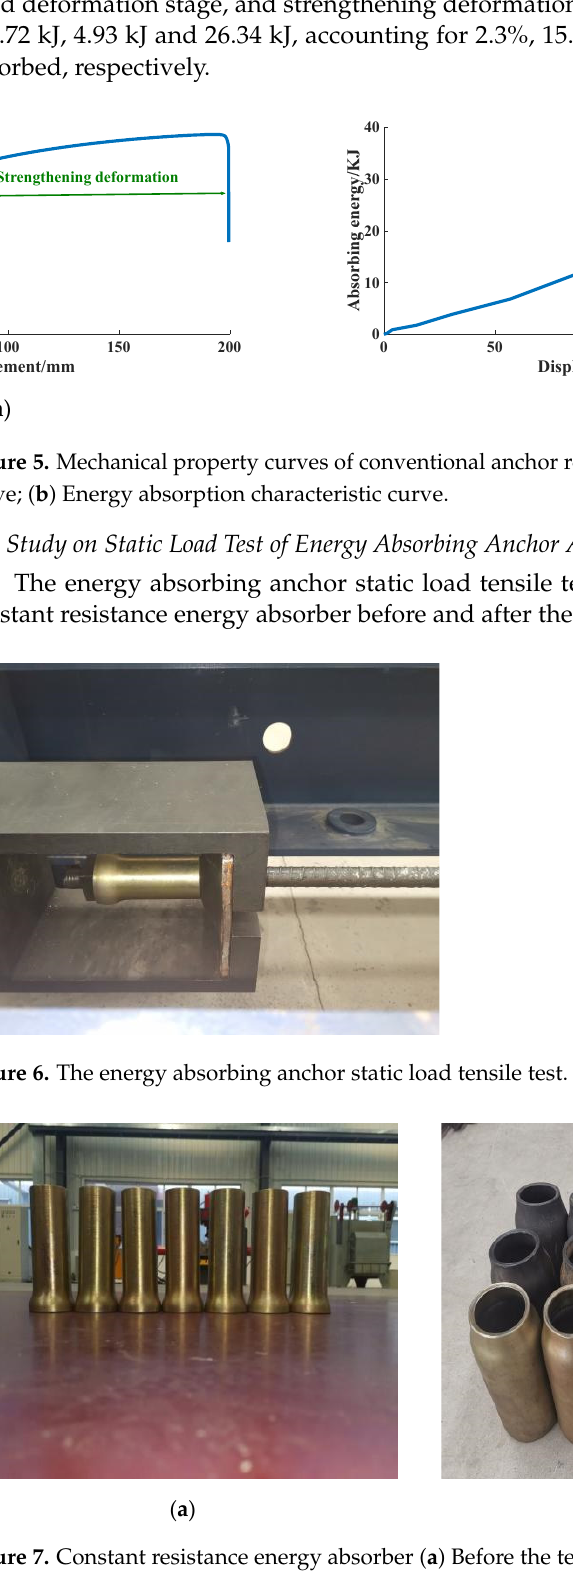
Figure 7. Constant resistance energy absorber ( a ) Before the test; ( b ) After the test. The comparison of the mechanical property curves of the conventional anchor and the energy absorbing anchor under static load is shown in Figure 8, and the comparison during loading is shown in Table 3. ( b ) Figure 8. The comparison of the mechanical property curves ( a ) bearing capacity-displacement curve; ( b ) energy absorption characteristic curve. Table 3. Comparison of the mechanical properties of the conventional anchor and energy absorbing anchor. Anchor Form Yield Distance/mm Absorbed Energy/kJ Damaged Load/kN conventional anchor